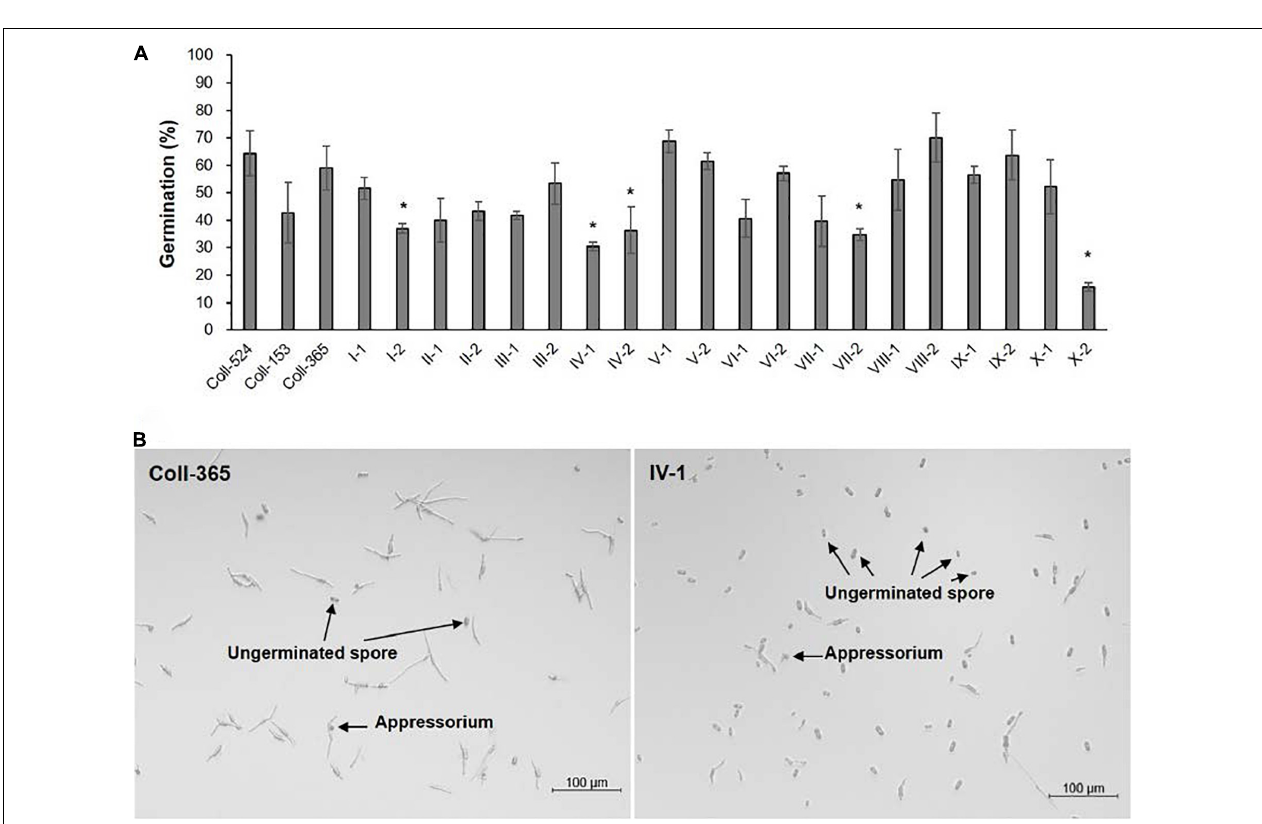
FIGURE 8 | Spore germination and appressorial formation of strains Coll-524, Coll-153, and Coll-365 and the transgenic strains of Coll-365. (A) Spore germination percentage of all assayed strains was presented. The significant difference between Coll-365 and other strains was indicated with a star when P < 0.5 appeared in two independent experiments after analysis with One-way ANOVA. (B) Spore germination and appressorial formation of strains Coll-365 and IV-1 in a plastic 96-well plate at 24 h post-incubation. Several ungerminated spores and appressoria are